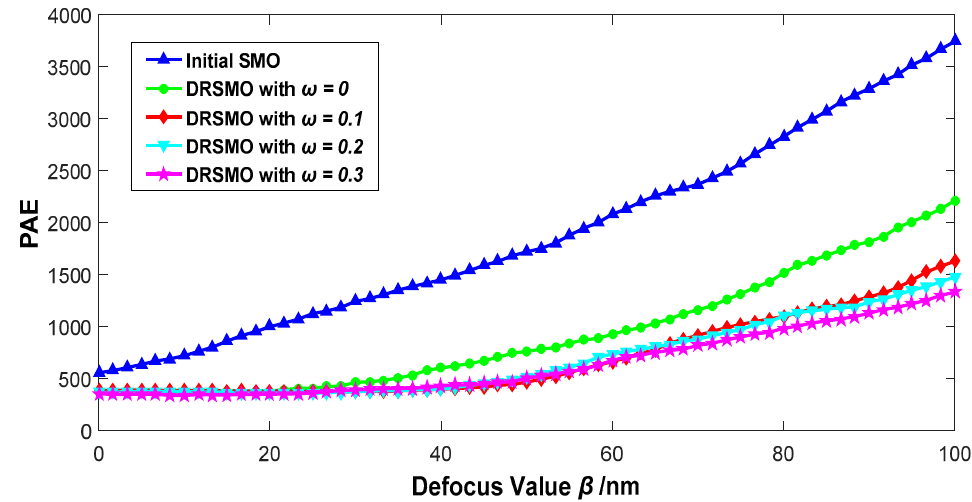
Figure 4. The defocus–pattern error (PAE) curves of target 1 for initial SMO (blue curve), the DRSMO with the weight factor ω = 0 (green curve), ω = 0.1 (red curve), ω = 0.2 (azury curve), and ω = 0.3 (purple curve). Optimizations were proceeded by the MBGD algorithm.